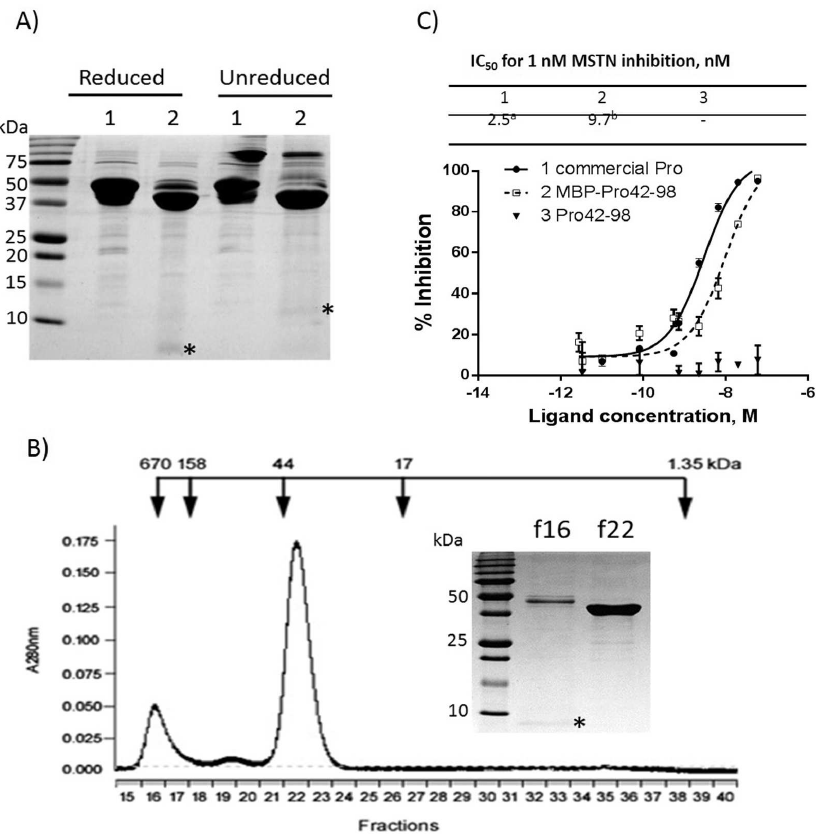
Fig 7. SDS-PAGE analysis of MBP-Pro42-98 after factor Xa cleavageand examination of MSTN- inhibitory capacity of Pro42-98. (A) After incubation of MBP-Pro42-98 with factor Xa, the total reaction mixture was centrifuged at 10,000 g for 3 min. The supernatant (solublefraction) was subjectedto 15% SDS-PAGE analysisunder reducedand unreducedconditions, then visualizedwith Coomassie blue. * , Pro42-98. (B) The supernatantwas subjectedto gel filtration, and fractions 16 (f16) and 22 (f22) were subjectedto SDS-PAGE analysisunder reducedcondition. * , Pro42-98. (C) MSTN-inhibitory capacity of purifiedPro42-98(f16) was measuredusing the (CAGA) 12 -luciferasereporter gene assay. The means of IC 50 not sharingthe same superscript are different at P < 0.05.